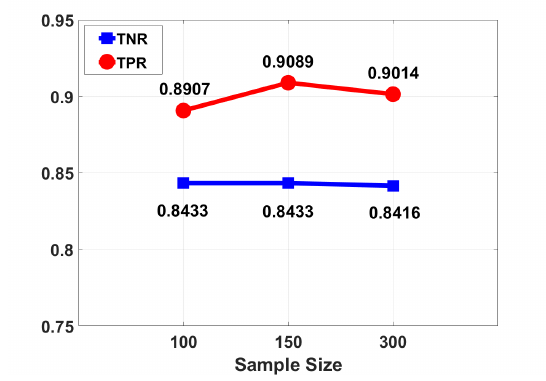
Figure 18. Performance results under different sample